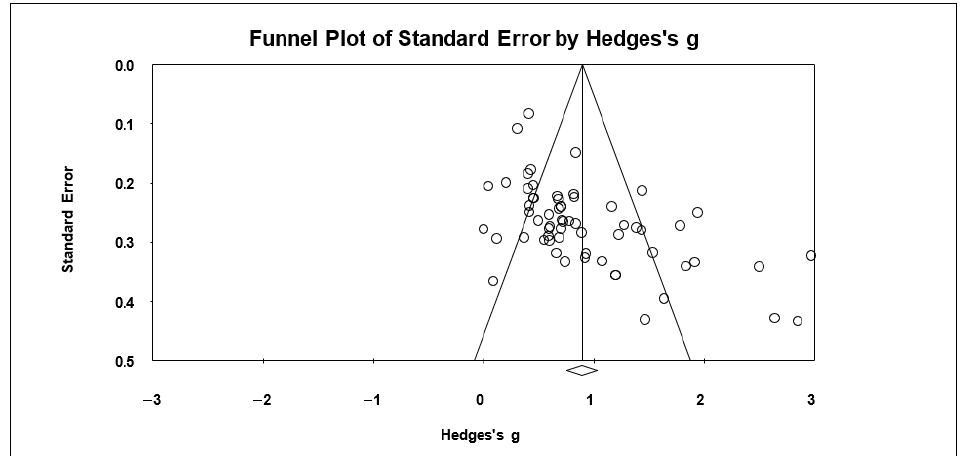
Figure 3. Funnel Plot of Standard Error by Hedges’ 𝑔 .